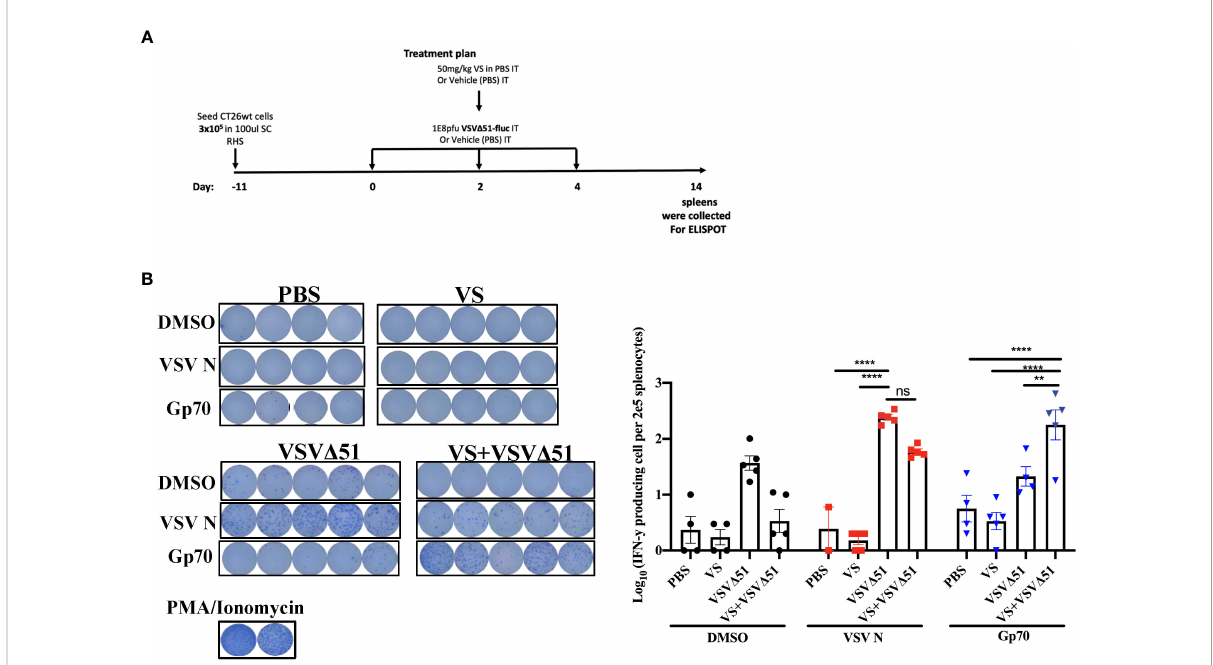
FIGURE 2 VS plus VSV D 51 combination therapy further induces antigen speci fi c immune response 14 days post treatment. (A) Schematic representation of the treatment schedule: after 12 days, CT26WT-tumor bearing mice received a total of three doses delivered intratumorally of vanadyl sulfate (50mg/kg) and VSV D 51- fl uc (1E8 PFU) or monotreatment injections with PBS, vanadyl sulfate (50mg/kg), or VSV D 51- fl uc (1E8 PFU) alone over 5 days. (B) Representative plates from an ELISPOT assay, splenocytes from treated mice were processed 14 days post treatment, then co-cultured with either DMSO, VSV N, or gp70 peptides for 20 hours, PMA and ionomycin were used as a positive control. Graph shows quanti fi cation of